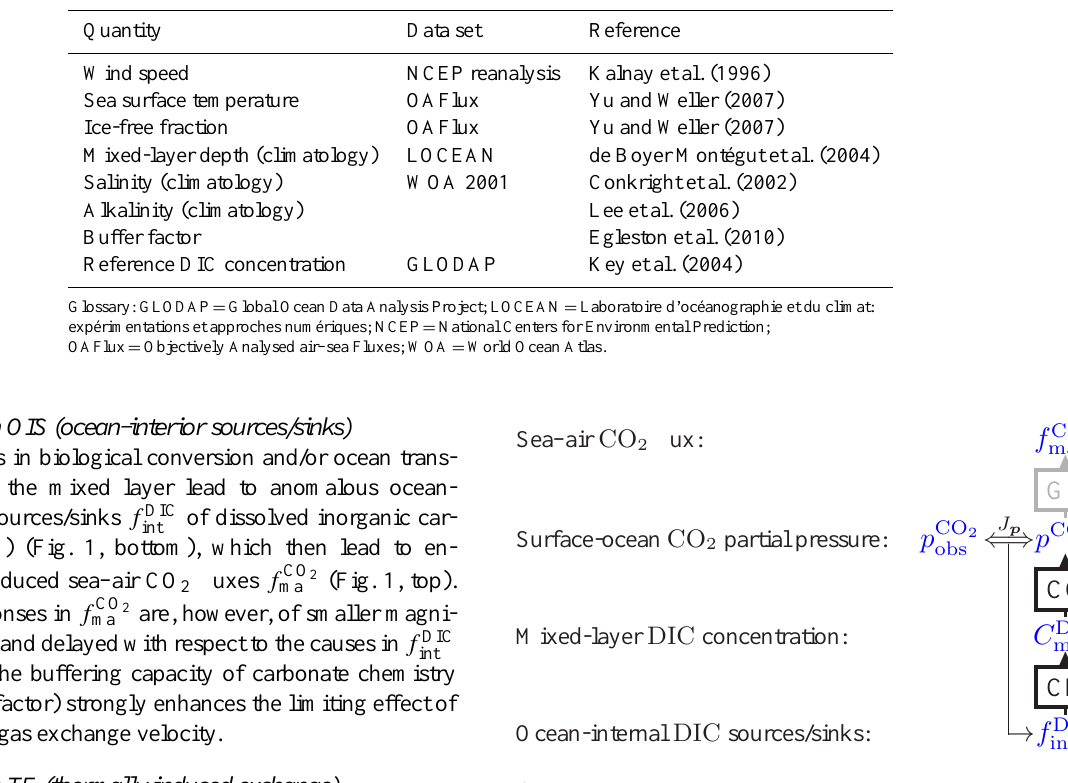
Fig. 2. Information flow between carbon and oxygen variables. Left: Inverse procedure of run SFC as in Fig. 1, estimating ocean- internal DIC sources/sinks from p CO 2 m data. Middle: Prediction of the oxygen sea–air flux: Ocean-internal oxygen sources/sinks are calculated from DIC sources/sinks via tracer-tracer coupling (TT) assumed to follow Redfield stoichiometries. Dissolved oxygen con- centration ( C O 2 m ) and sea–air oxygen flux ( f O 2 ma ) are then obtained from parameterizations of a mixed-layer oxygen budget (OB), as well as oxygen solubility and sea–air gas exchange (GE), analo- gous to those for carbon. Right: APO inversion of R¨odenbeck et al. (2008): Sea–air APO fluxes are estimated from APO observations (combined atmospheric oxygen and CO 2 data) by inversion of at- mospheric transport (AT).